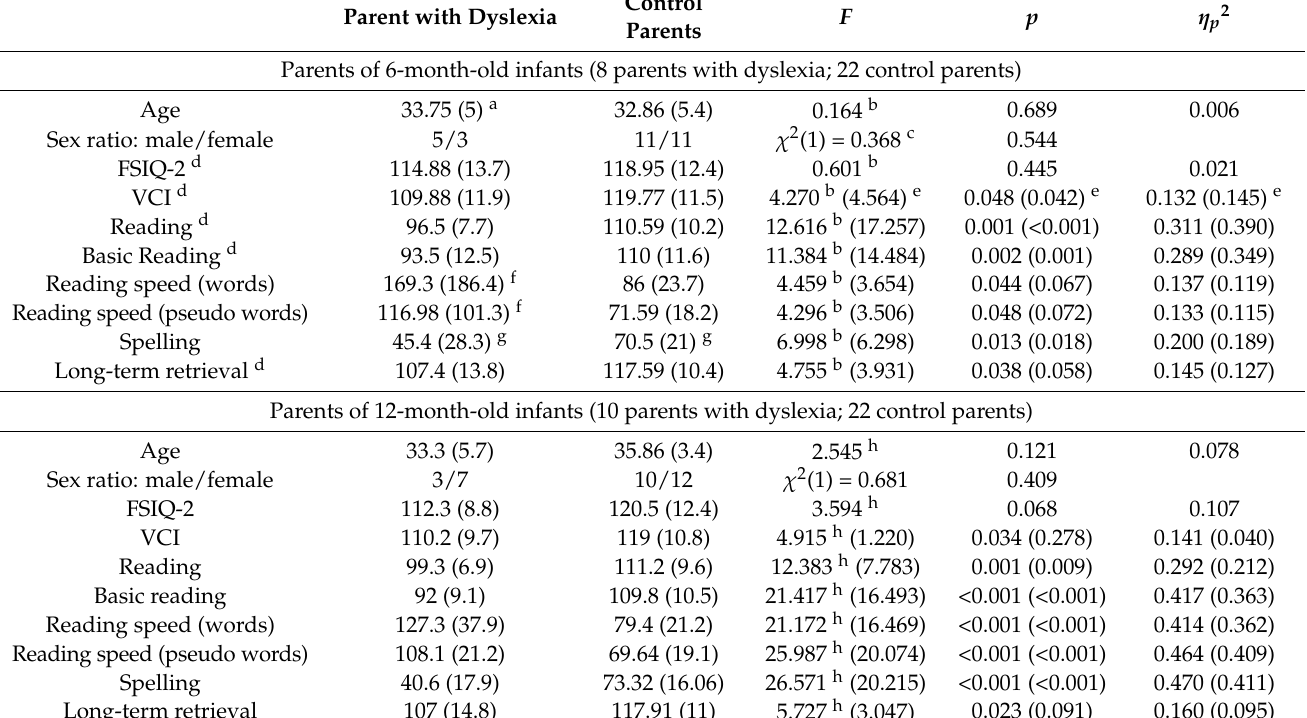
Table 1. Cognitive test results for parents of 6- and 12-month-old infants. Parent with Dyslexia